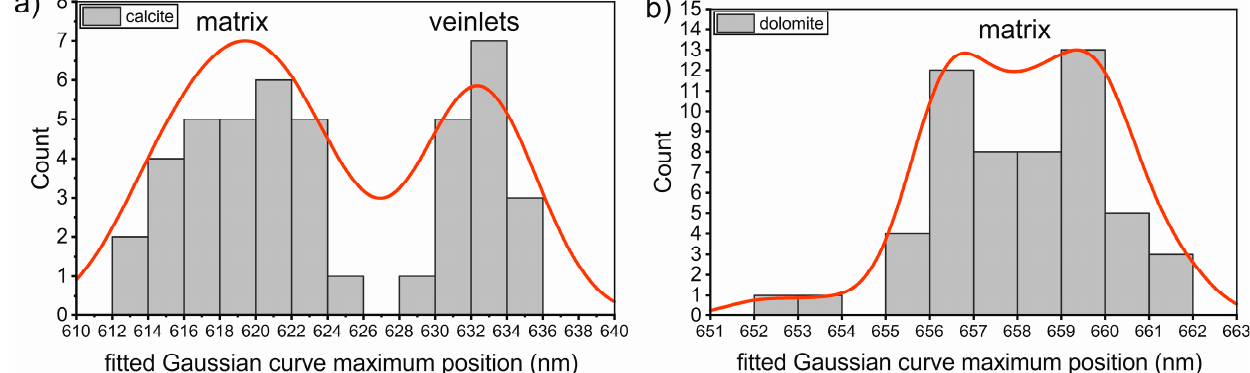
Figure 6. Comparison of the position of the centre of a single Gaussian curve for CL-spectra corre- sponding to calcite ( a ) and dolomite ( b ). Note a clear bimodal distribution for calcite data and rather unimodal for dolomite ones. Note that there is a much smaller range of data plotted along the hor- izontal axis for dolomite than for calcite grains.